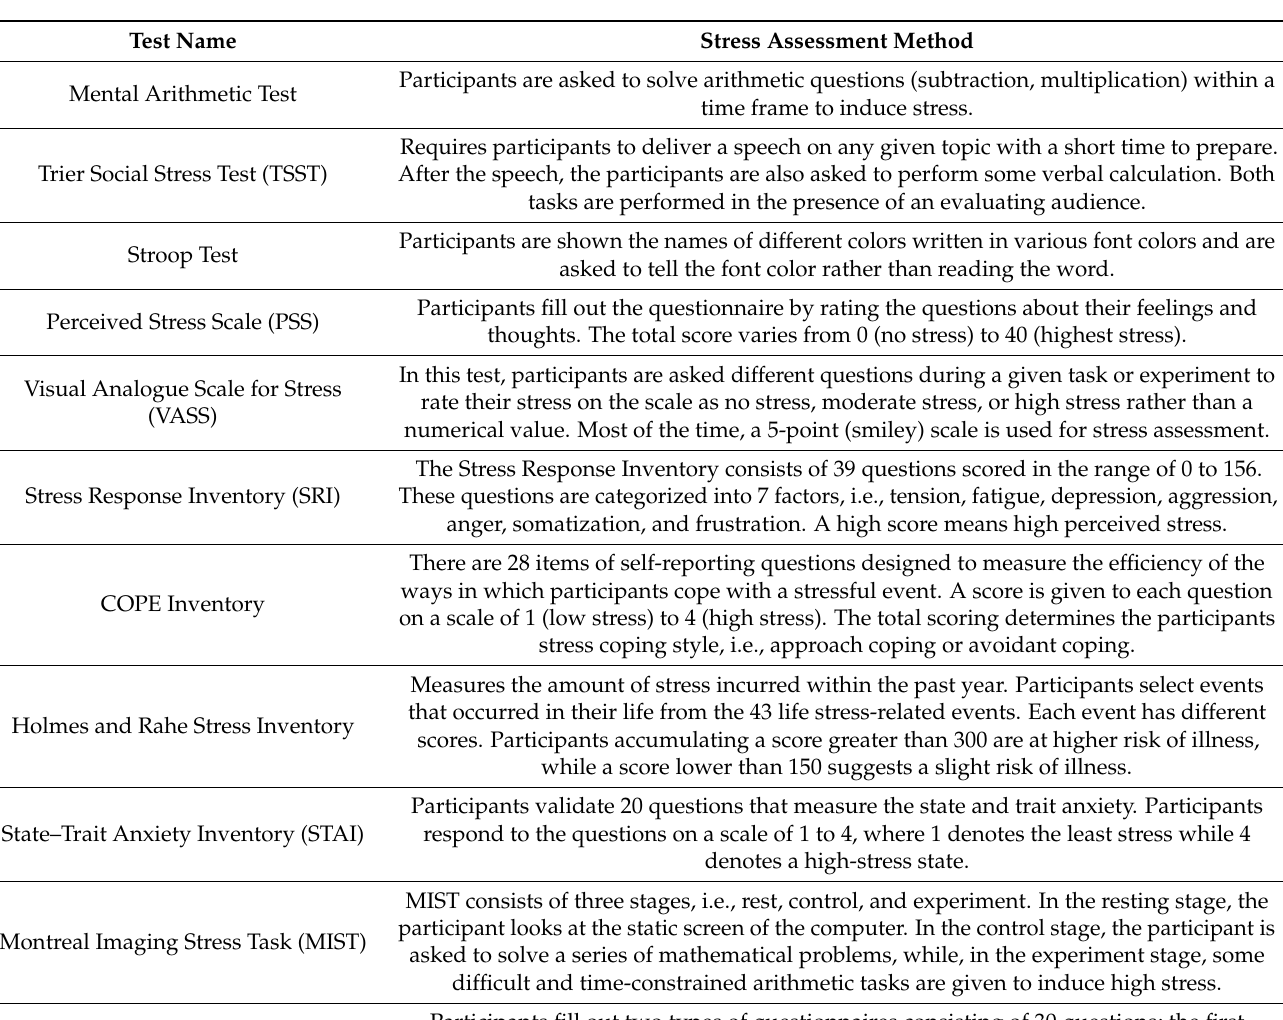
Table 1. Stress assessment test and brief